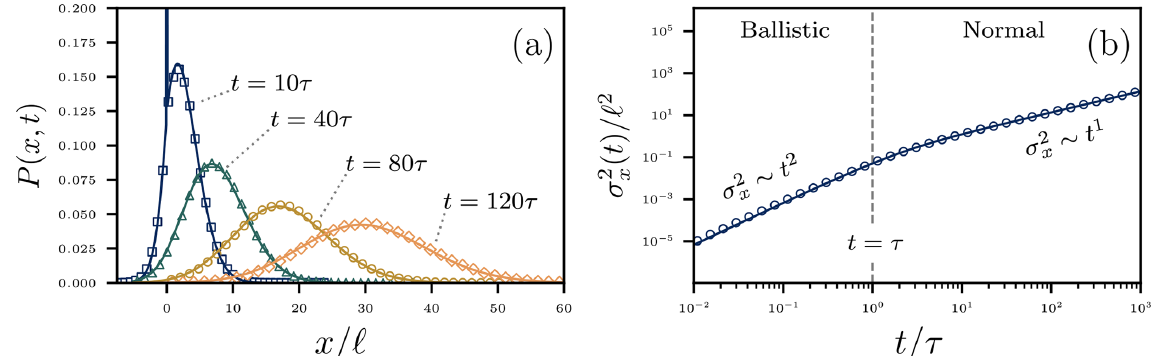
Figure 3. Panel (a) indicates the overdamped probability distribution of particle position (Eq. 19) as it evolves through time, while panel (b) shows the resulting particle diffusion from Eq. (20). All results are scaled by the mean hop length (cid:96) = V/k D and the timescale τ = 1 /k of the motion–rest alternation. Curves represent the analytical results, while the points are results of Monte Carlo simulations of the exact Eq. (5) produced by evaluating the cumulative transition probabilities on a small time step (e.g., Barik et al., 2006). In panel (a) from the initial mixture of motion and rest states, particles advect downstream as they diffuse apart from one another due to motion–rest alternation and velocity variations. The initial distribution persists as a delta function spike for the t = 10 τ curve. In panel (b) at timescales t (cid:28) 1 /k the diffusion is approximately ballistic since particles have not had time to exchange between motion and rest. For t (cid:29) 1 /k particles undergo normal diffusion as particles become well-mixed among motion and rest states. Small discrepancies are visible at short times between the simulations and analytical approximations due to our neglect of velocity fluctuations in deriving Eq.